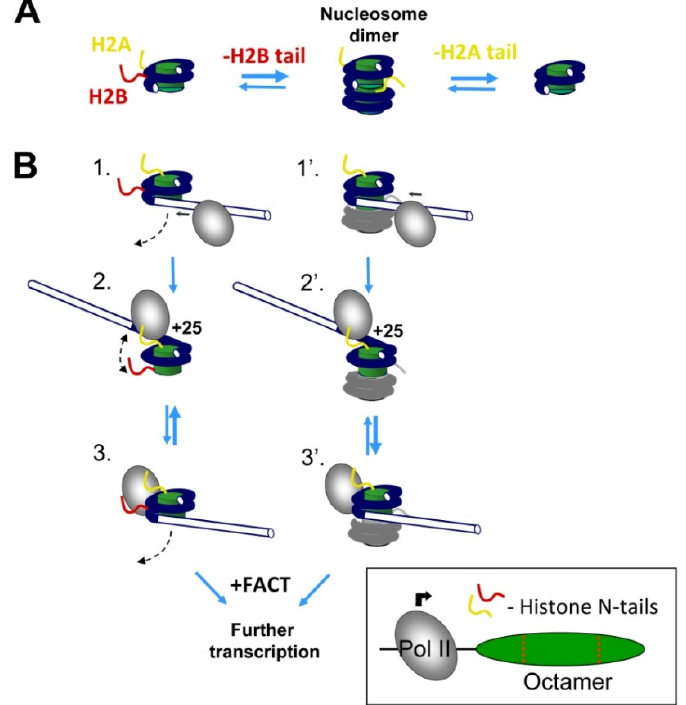
Figure 6. A model: the role of N-terminal tails of histones H2A and H2B during Pol II transcription. ( A ) N-terminal tails of histones H2A and H2B strongly affect nucleosome dimerization. Only one histone tail per nucleosome is shown for clarity. ( B ) Effect of histone tails on transcription by Pol II. When Pol II approaches a nucleosome (intermediates 1 and 1 ′ ), the nucleosomal DNA in front of Pol II is partially and transiently uncoiled from the histone octamer (intermediates 2 and 2 ′ ); only the uncoiled state is permissive for Pol II progression along the +(11–27) region of nucleosomal DNA [5,58,59]. The promoter-proximal N-tail of histone H2B stabilizes the contacts of nucleosomal DNA to the histone octamer at the +25 region (intermediates 3 and 3 ′ ), shifting the equilibrium between the coiled and uncoiled states, and inhibiting Pol II passage through this region. In the presence of FACT, the equilibrium is shifted towards the uncoiled state [12], favoring more efficient transcrip- tion. Although removal of the N-tail of histone H2B facilitates formation of nucleosome dimers, this dimerization only minimally affects transcription through the nucleosome.